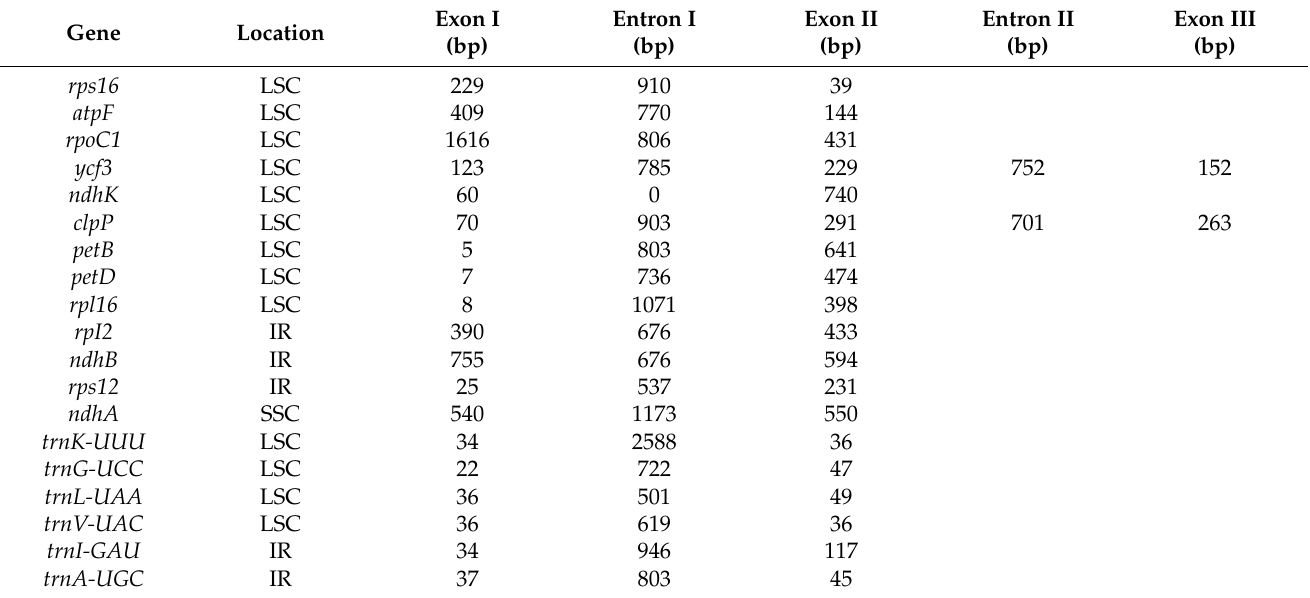
Table 2. List of the intron-containing genes in the plastome of Ficus populifolia along with the lengths of their introns and exons.